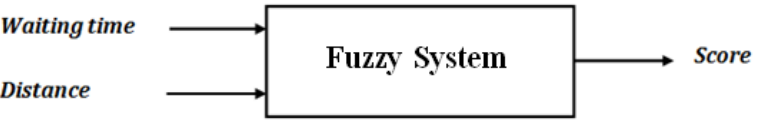
Figure 2. Input and output variables of fuzzy model.